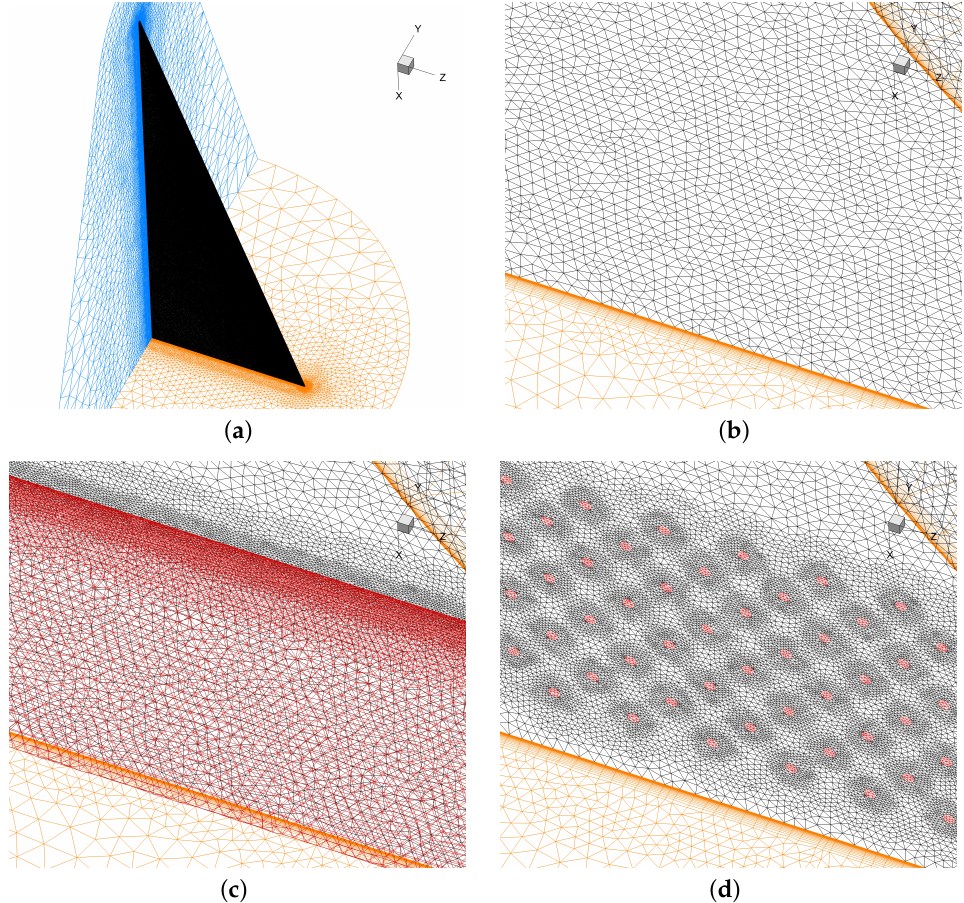
Figure 7. Computational Mesh. (Blue: Symmetry Plane; Orange: Outlet; Black: Model Surface; Red: Body Flap and AJM). ( a ) Mesh Overview, ( b ) Baseline Mesh, ( c ) Mesh of Mechanical Control Surface, ( d ) Mesh of